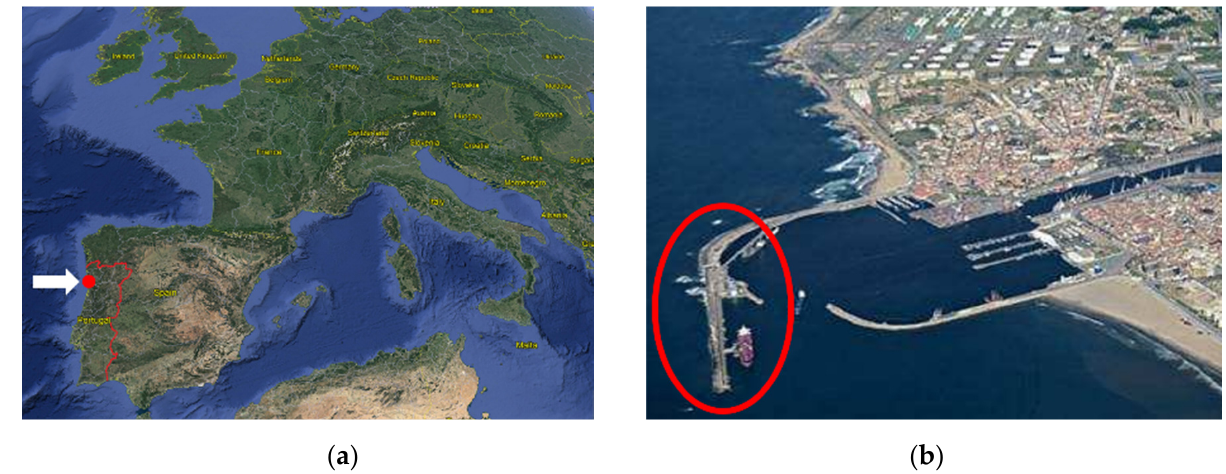
Figure 1. Port of Leixões: ( a ) location in the Iberian Peninsula and ( b ) aerial view of the port and its breakwaters (north breakwater highlighted).